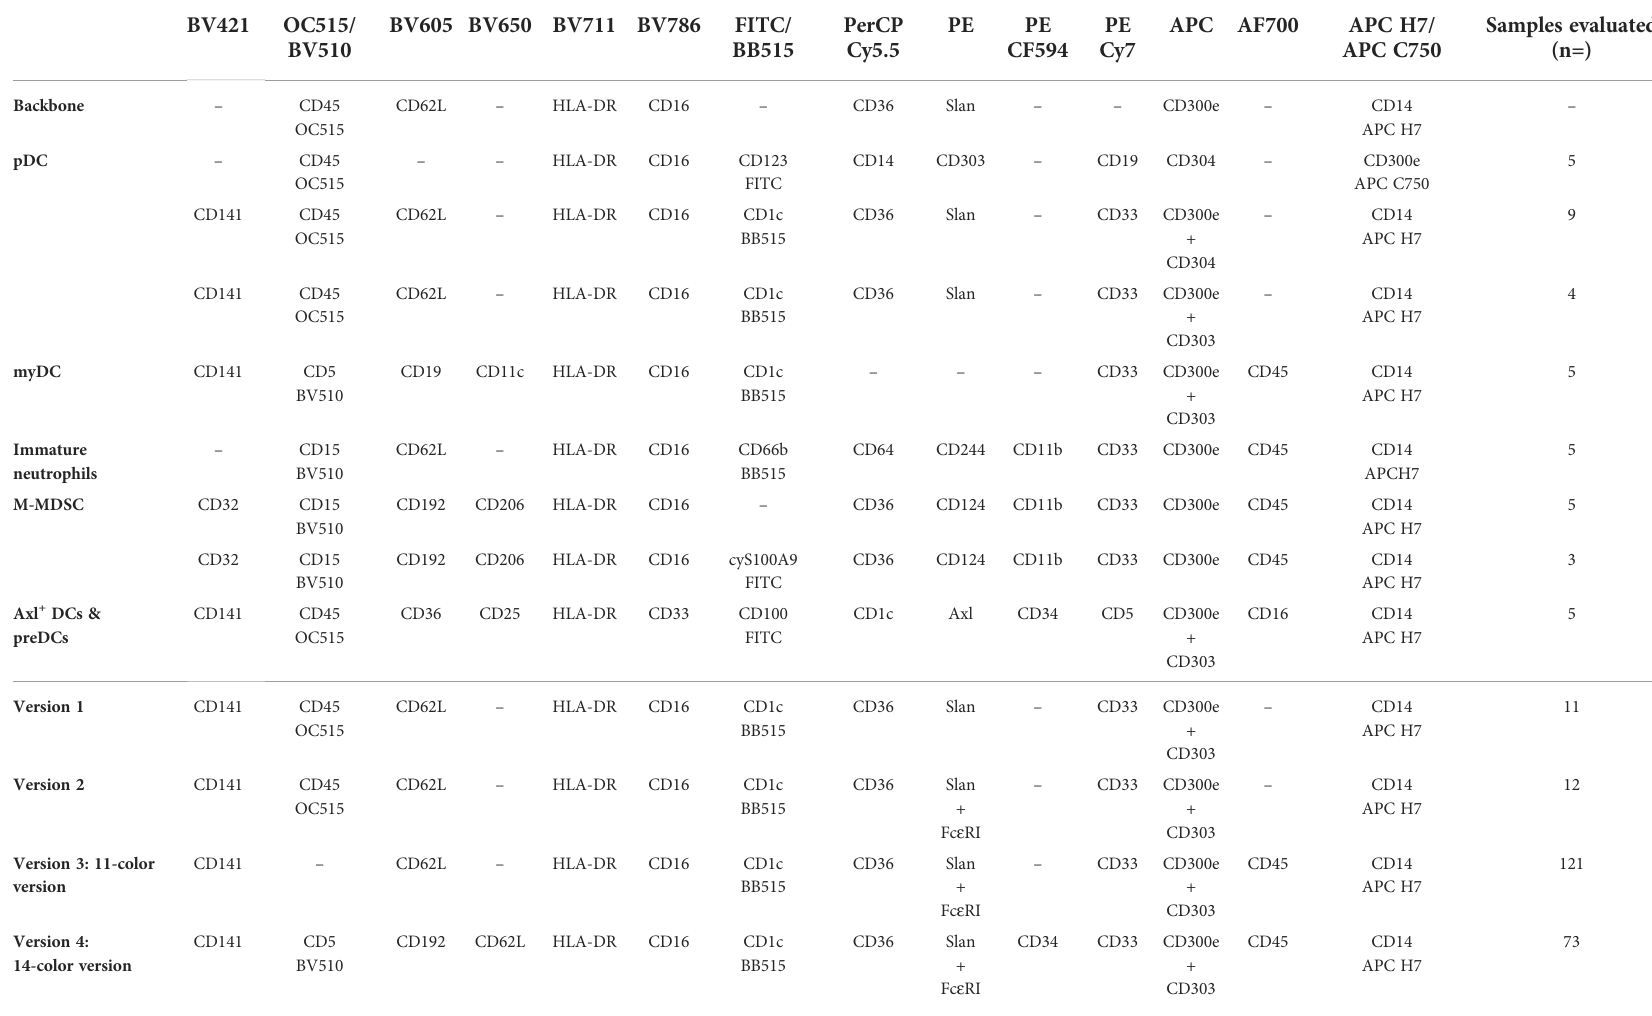
TABLE 1 Antibody combinations used to stain peripheral blood for the selection of the best marker combination for identi fi cation of the different innate myeloid cell populations, and overview of the distinct versions evaluated during the multiple design cycles (four rounds) of the EuroFlow innate myeloid cell (IMC) fl ow cytometry